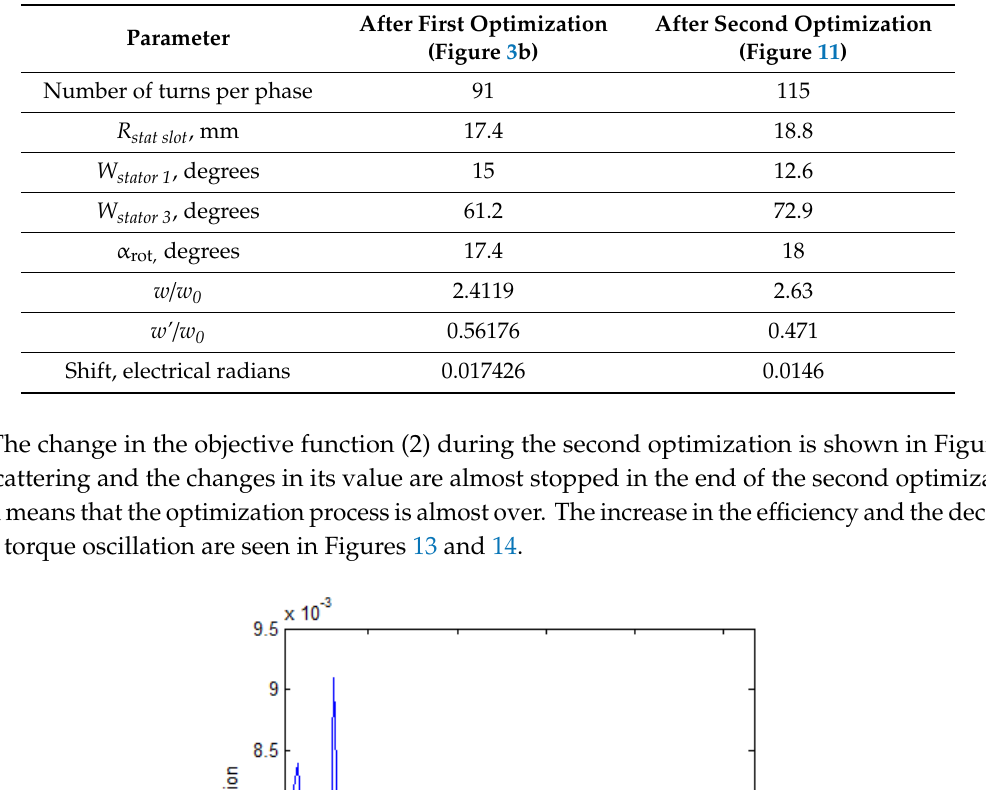
Table 5. The FRM parameters varied during the second optimization.